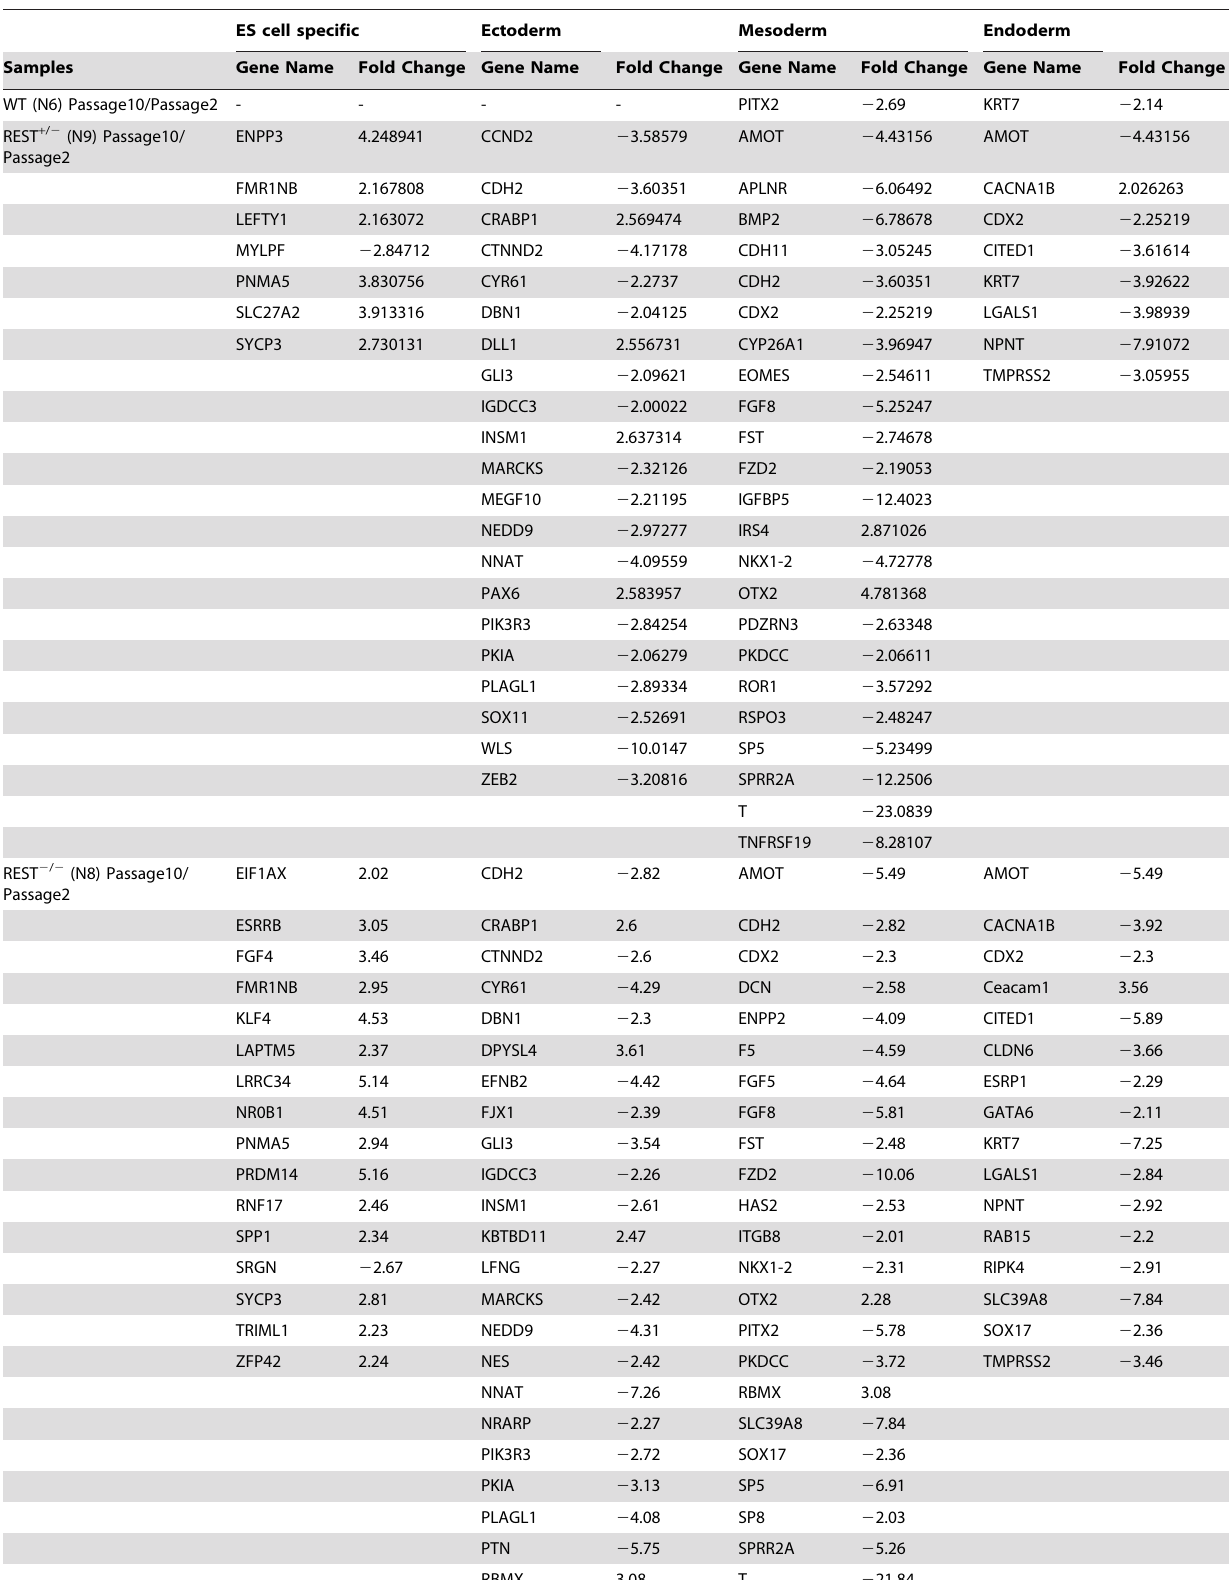
Table 2. Comparison of expression levels of genes for WT (N6), N9 (Rest + / 2 ) and N8 (Rest 2 / 2 ) during the transition between passage 2 and passage 10 when cultured on